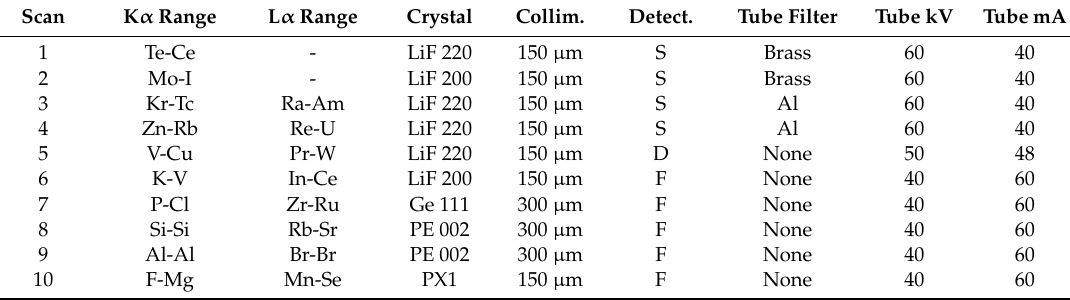
Table 4. Operation conditions for the XRF scans used in the IQ + program. Rh anode X-ray tube used for these scans. Collim. = collimator, Detect. = detector. Al tube filter is 200 µ m thick, brass tube filter is 100 µ m thick for scan number 1 and is 300 µ m thick for scan number 2. F = flow detector, D = duplex detector, S = scintillator detector. The flow detector uses an Ar-CH 4 gas